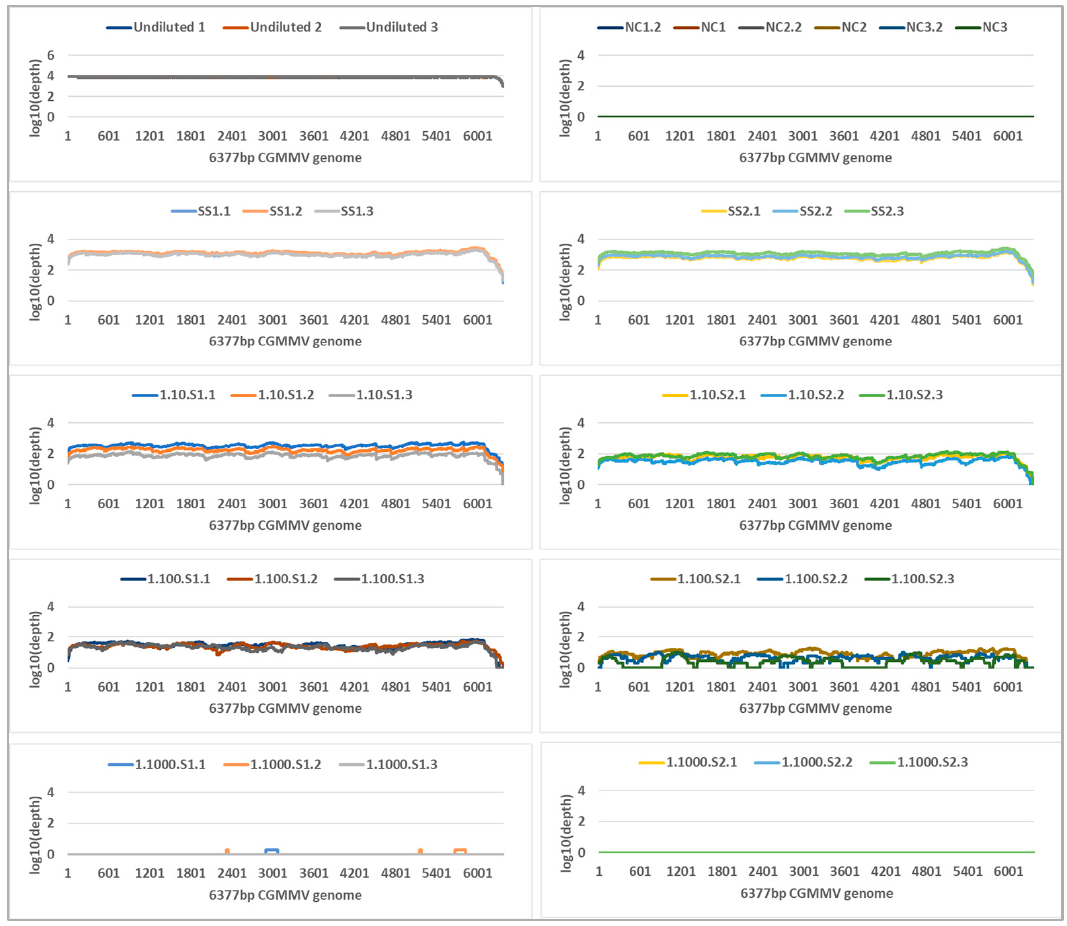
Figure 5. Genome coverage and read depth profiles of seed panel dilution series samples, from undiluted to 1 in 1000 across the 6377 nt reference cucumber green mottle mosaic virus (CGMMV) genome (NSW3-35) detected using Illumina metagenomic sequencing. Biological replicates are shown in each profile. Each biological replicate was tested in triplicate and the results for each technical replicate are shown as different colours. Depth is in standard logarithmic scale.